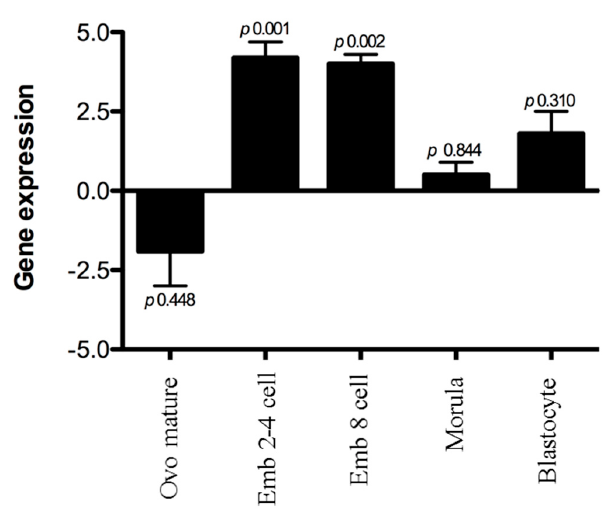
Figure 2. Expression of the ashwin gene in bovine embryos at different stages, normalized to expression levels of the ashwin gene using the 2- ∆∆ CT method. Expression in immature oocytes served as a reference. Dunnett multiple comparison tests were performed.